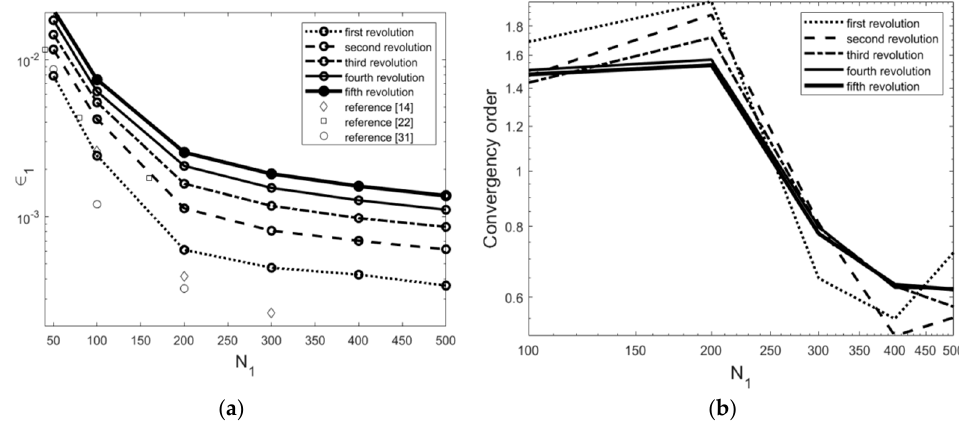
Figure 11. ( a ), The values of the (cid:101) 1 norm during the revolutions for various structured mesh spacing, as well as the comparison with PDE-based re-initialization methods [14,22,31] ( b ), The values of the convergency order during the revolutions for various structured mesh spacing.